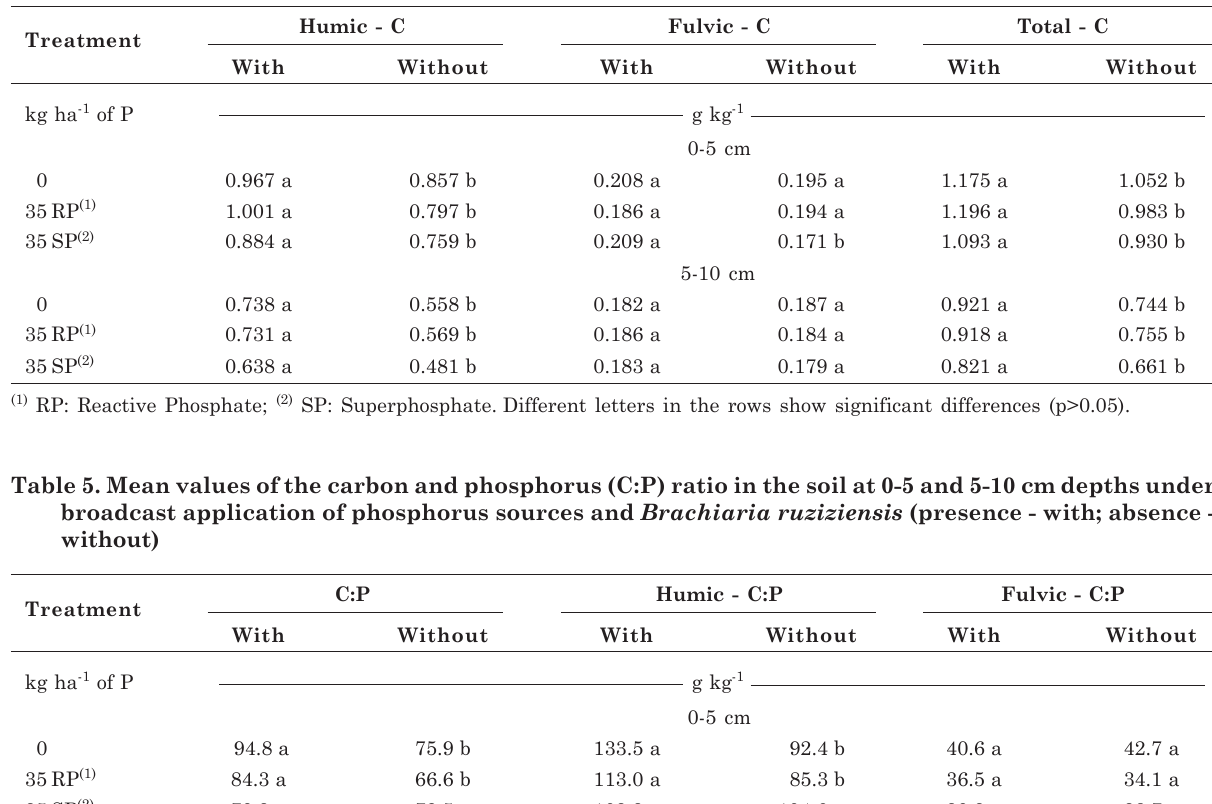
Table 4. Mean values of dissolved carbon in the extractant 0.5 mol L -1 NaOH in the humic fraction (Humic - C), fulvic fraction (Fulvic - C) and Total (Total - C) in the soil at 0-5 and 5-10 cm depths under broadcast application of phosphorus sources and Brachiaria ruziziensis (presence - with; absence -